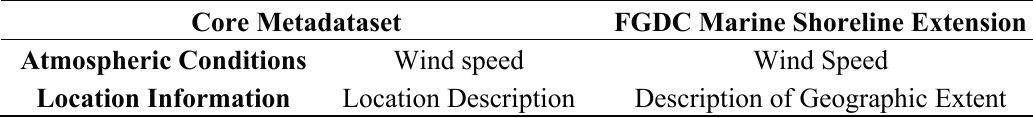
Table A7. Mappings from FGDC Content Standard for Digital Geospatial Metadata (Shoreline Metadata Profile) to the Core